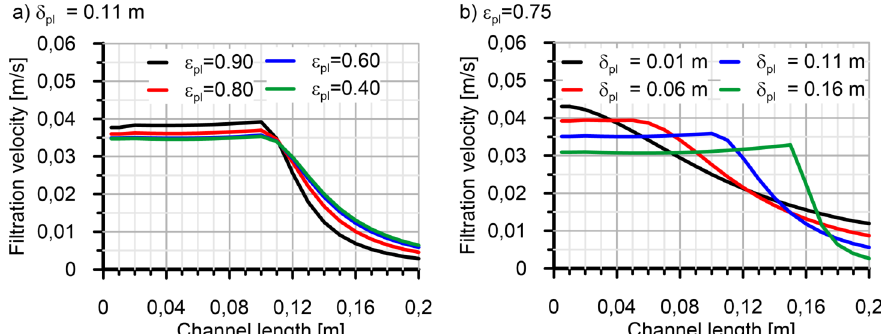
Figure 9. Filtration velocity profile as a function of the soot mass distribution onset and the particulate layer porosity after the first water injection event in DPF #A.